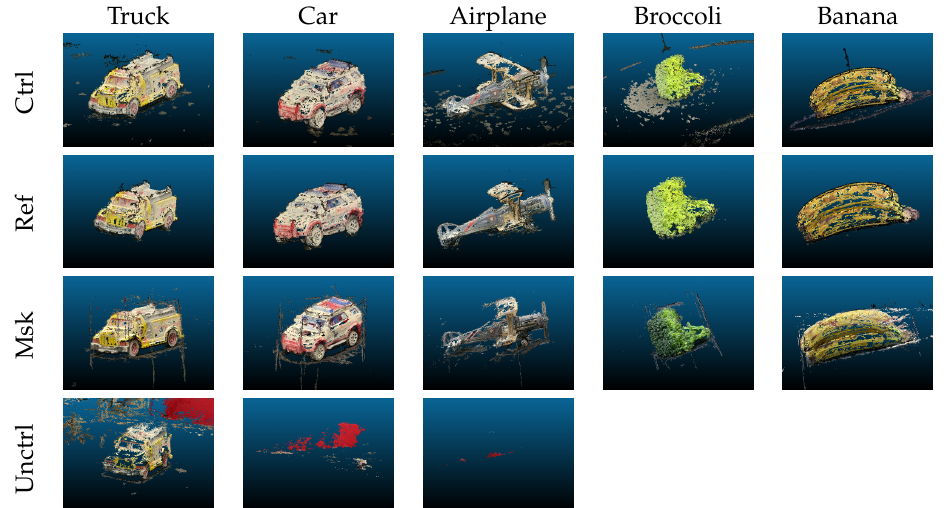
Figure 7. Example results using Pix4d for various models showing the four resulting point clouds from out experiments. Ctrl—using controlled environment, Ref—hand cleaned version of Ctrl, Msk—uncontrolled environment masked using our pipeline, Unctrl—uncontrolled